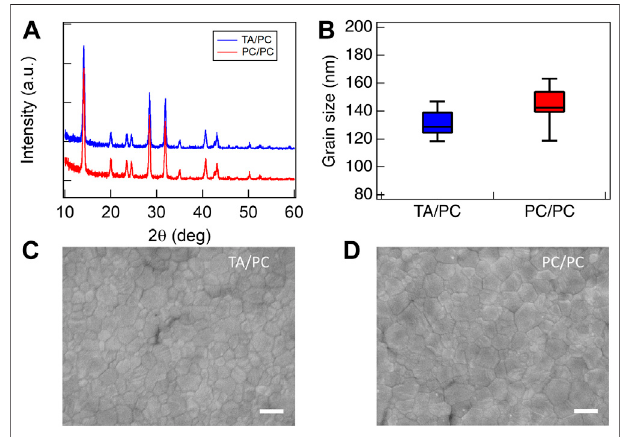
FIGURE 1 | (A) XRD patterns of PC MAPbI 3 on top of TA and PC NiO x . (B) Statistical analysis based on low magni fi cation SEM images ( Supplementary Figure S5 ). Top-view SEM images of PC MAPbI 3 on top of (C) TA NiO x and (D) PC NiO x (scale bar (cid:2) 200 nm).